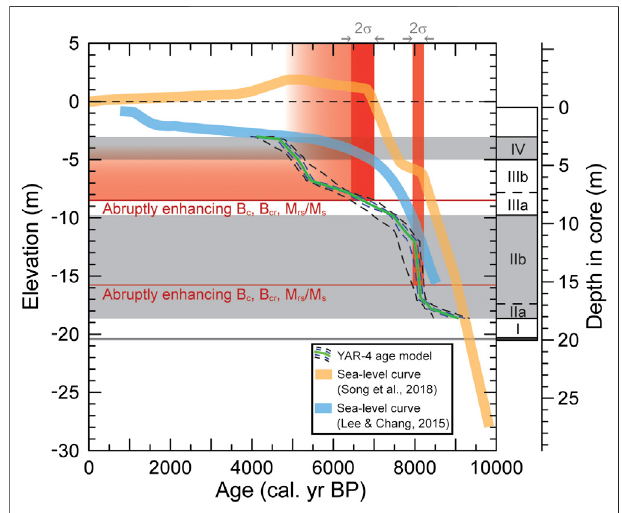
FIGURE 12 | Comparison of our age-depth model for the YAR-4 core with two different suggested sea-level curves for the western coast of South Korea (Lee and Chang, 2015; Song et al., 2018). HBBM intervals (characterized by subtantially high B c , B cr , and M rs /M s values) and their corresponding ages are indicated by red lines and red shaded boxes. The YAR-4 age-depth model curve with the uncertainties are the same as in Figure 3 . Sedimentary unit divisions are also supplementarily